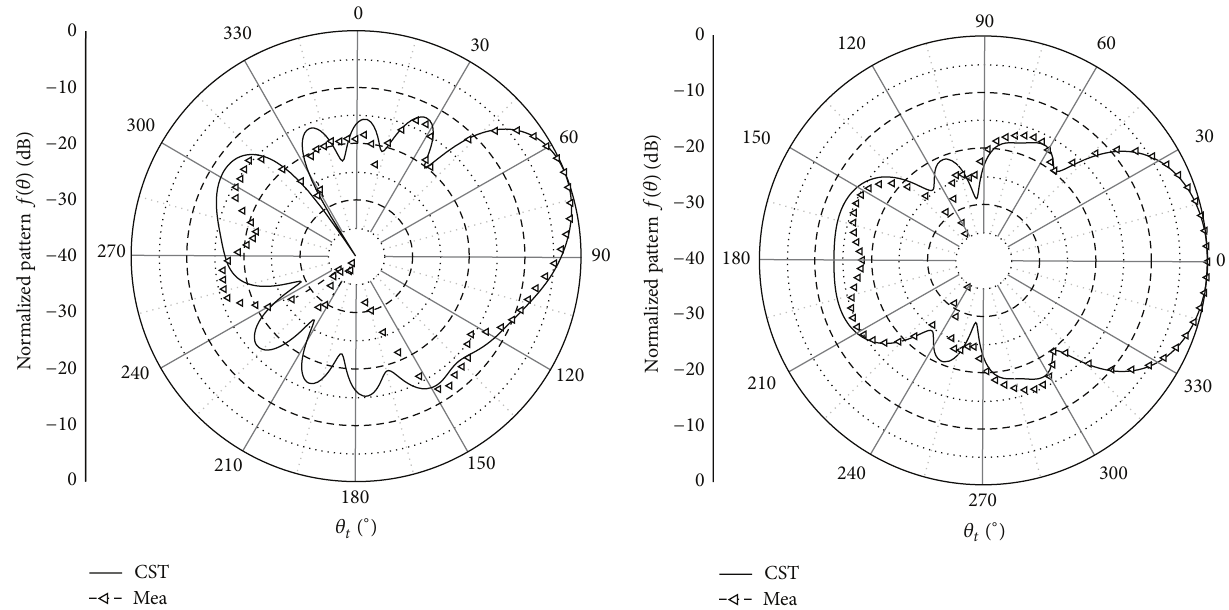
Figure 10: Measured radiation pattern for the 10-element monopole Yagi-Uda antenna shown in Figure 9.